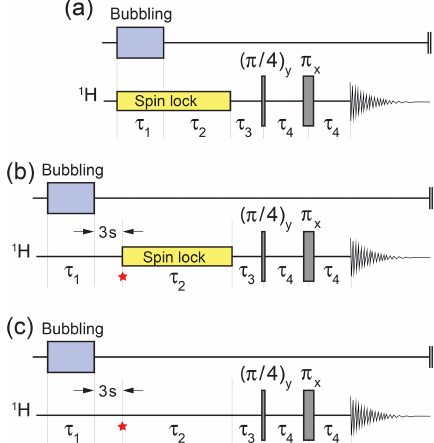
Figure 3. Experimental timing sequences. (a) Procedure for the demonstration of gem -PHIP. Bubbling of para -enriched H 2 is con- ducted for an interval τ 1 in the presence of a radio-frequency spin- locking field in order to suppress singlet–triplet mixing in the re- action product I . The spin locking continues for a further interval τ 2 , followed by a two-pulse sequence to convert the hyperpolarized singlet order to in-phase magnetization (Sarkar et al., 2007). The ex- perimental delays were τ 3 = 6 . 49ms and τ 4 = 14 . 97ms. (b) Proce- dure for demonstrating the accumulation of the singlet order during spin locking. The spin-lock field is applied during the variable in- terval τ 2 , with an amplitude corresponding to a nutation frequency ω nut / (2 π ) = 1 . 0kHz. The star symbol refers to the time point dis- cussed in the text. (c) The same sequence as for panel (b) but with- out spin locking during the variable τ 2 interval. The interval τ 1 was set to 90s for panel (a) and 17s for panels (b) and (c) .